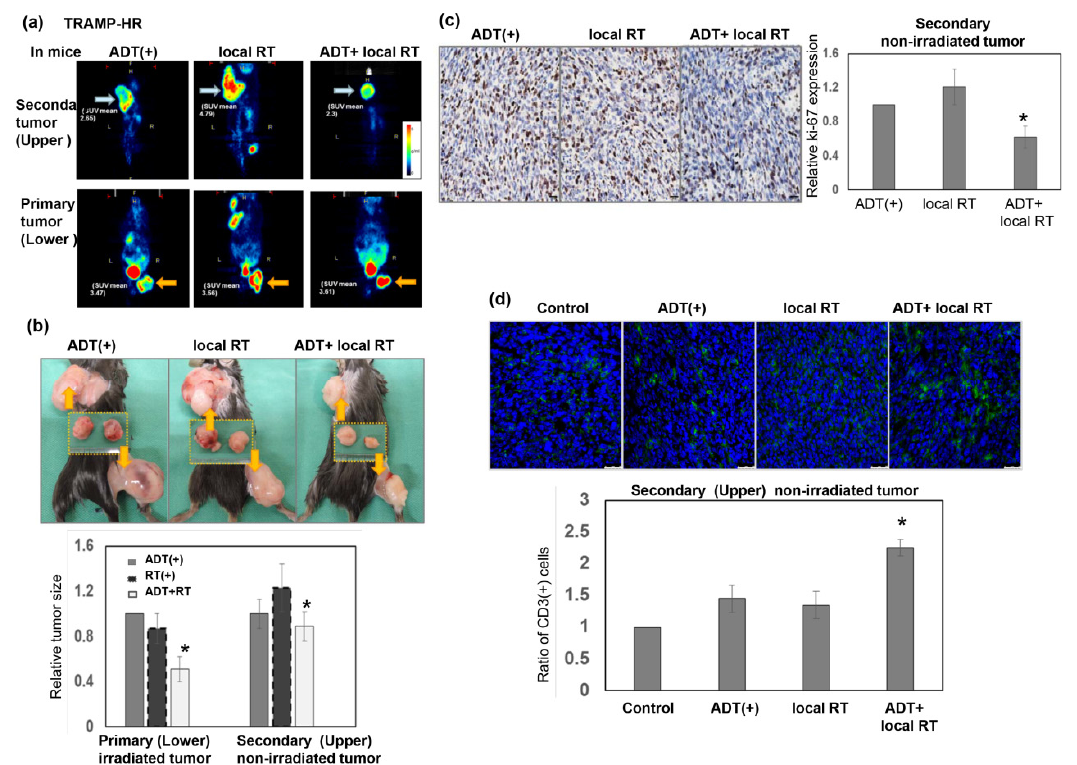
Figure 5. Role of RT in the response of metastatic CRPC to ADT. ( a ) Representative PET images from the tumor-bearing mice 24 h after three times 8 Gy to the right thigh tumor only (orange arrow: Primary irradiated tumor; blue arrow: Secondary non-irradiated tumor). ( b ) Representative images from the tumor-bearing mice 7 days after three times 8 Gy to the right thigh tumor only (right thigh tumor: Primary irradiated tumor; upper back tumor: Secondary non-irradiated tumor). The y axis represents the relative ratio, normalized to the tumor size of primary CRPC tumors in sham-irradiated mice treated with ADT (* p < 0.05). ( c ) Expression levels of Ki-67 of the secondary non-irradiated tumors were evaluated by IHC analysis. Representative images (Scale bars: 20 µ m) and quantitative data are shown. The y axis represents the relative ratio, normalized to the value of secondary non-irradiated tumors in enzalutamide-treated mice (* p < 0.05). ( d ) The extent of TILs of the secondary non-irradiated tumors was examined by immunofluorescence analysis using tumor specimens that underwent CD3 staining in mice bearing ectopic tumors. Scale bars: 50 µ m. The quantification was the calculation of the value of the cell numbers positive for CD3 divided by the total cell number. The y axis represents the ratio normalized by the value under control conditions.